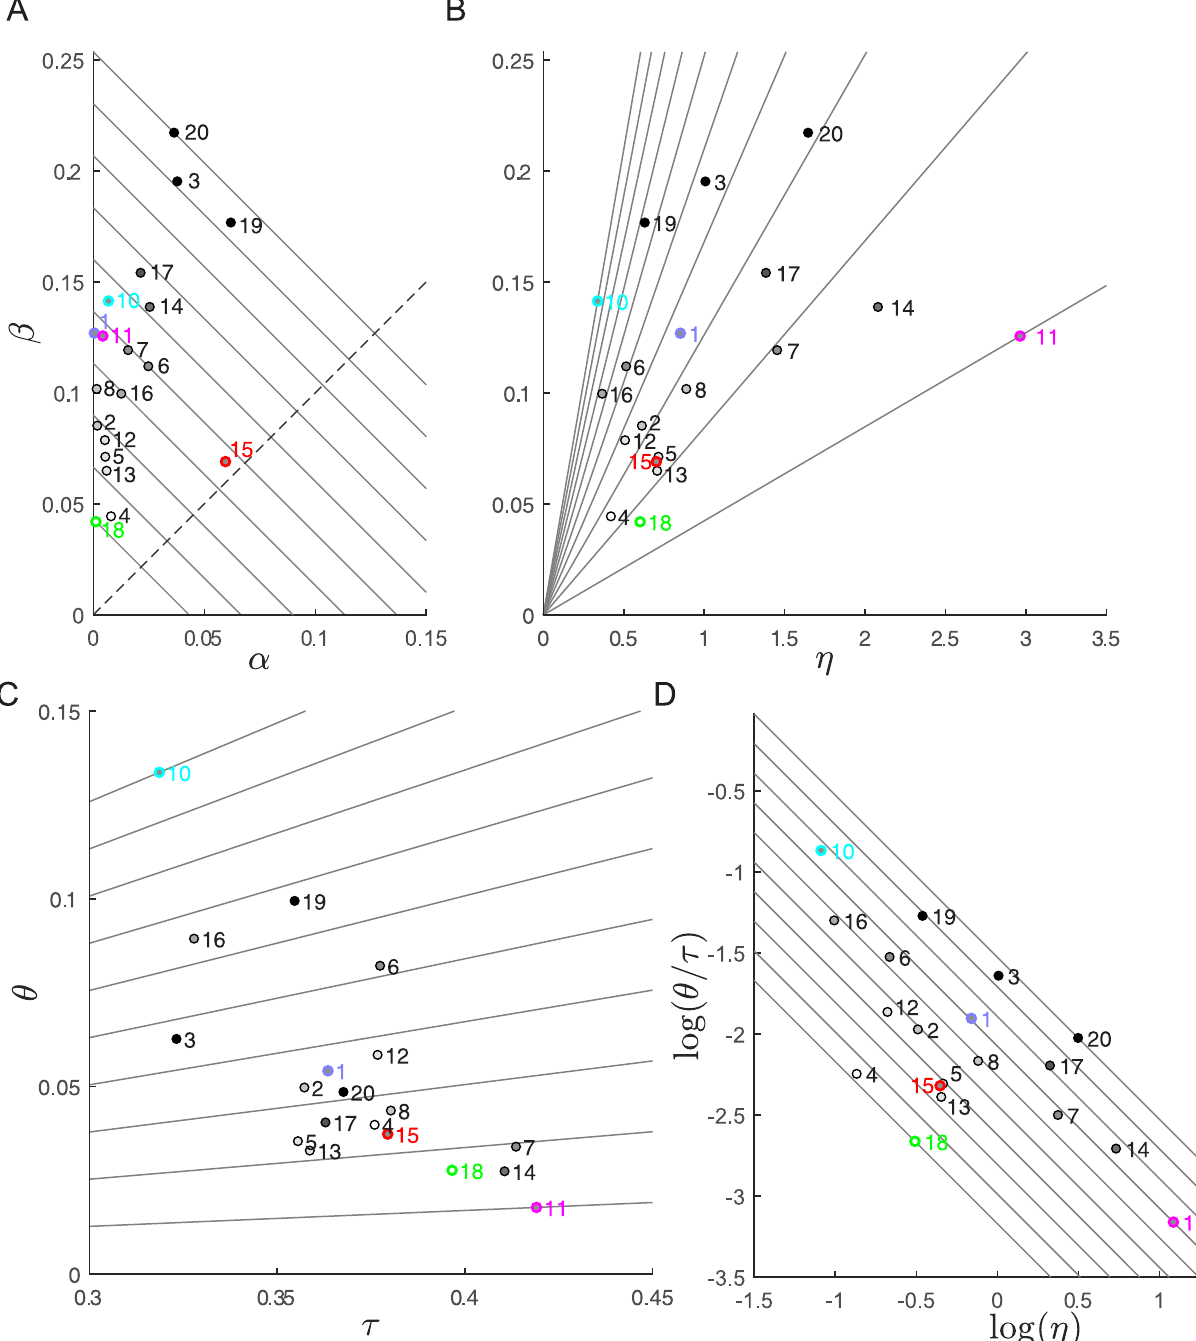
Fig 7. Decomposition of the mean score across participants for target T1. Circular markers are filled with areas that are gray-shaded according to the score (lighter gray for lower mean score). The edge of the markers corresponding to the five participants of Fig 5 are colored with matching colors. To increase the readability of the figure, P 9 is not shown. (A) The α − β plane and the iso-performance lines. The dashed line represent the direction of maximal change in performance (orthogonal to the iso-performance lines). (B) The β − η plane. The lines have slopes corresponding to different values of y . Participants along the same line, such as P 1, P 2, and P 12, t have the similar alignment-to-tolerance ratio and the difference in their β are only due to the noise η . (C) The θ − τ (tolerance-alignment) plane. The lines have slopes corresponding to different values of b . The negative correlation between θ and τ indicates that participants with mean release action in a region with higher tolerance Z also tend to have lower alignment with the most noise sensitive directions. (D) The log ( η )- log ( θ / τ )plane and iso- β lines. As β is the product of θ / τ and η and log ( β ) = log ( θ / τ ) + log ( η ), in the log ( η )- log ( θ / τ )plane participants with the same β lie on a line with a − 1 slope and maximal change of the tolerance-variability index occurs along the orthogonal direction.